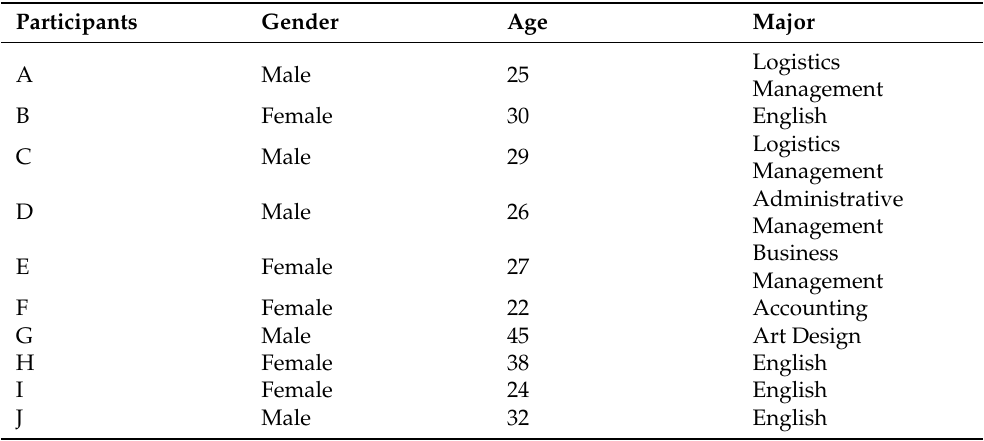
Table 2. Data related to the